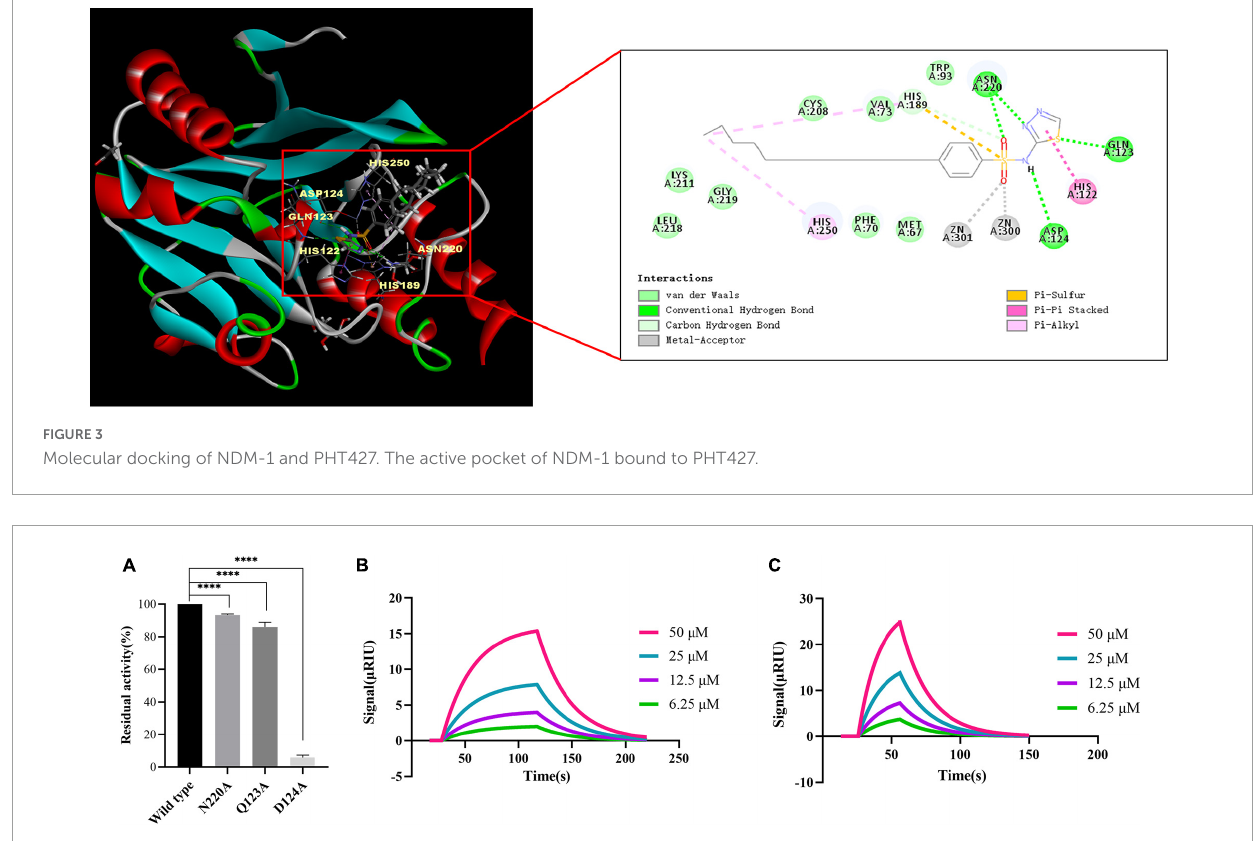
FIGURE4 Proving the importance of Asn220 and Gln123 for maintaining the stability of PHT427 and NDM-1 binding. (A) Residual activity of wild-type NDM-1, N220A, Q123A and D124A at concentration of 0.25 µ g/mL. ∗∗∗∗ was indicated as P < 0.0001. (B) Demonstration of the interaction between N220A and PHT427 by SPR, with a K D value of 8.96 × 10 − 4 M. (C) Demonstration of the interaction between Q123A and PHT427 by SPR, with a K D value of 1.24 × 10 − 4 M.